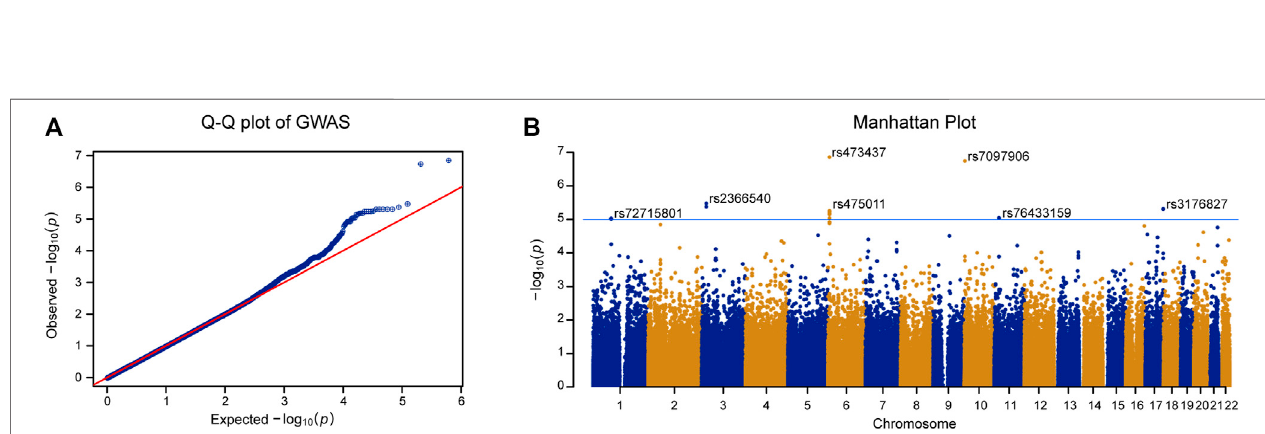
FIGURE 2 | GWAS of T-score in PMO patients. (A) Quantile-quantile plot of the GWAS p value. X-axis represents the expected p value. Y-axis represents the observed p value based on linear regression. Red line shows the theoretical distribution under the null hypothesis of no association in the data. (B) Manhattan plot of